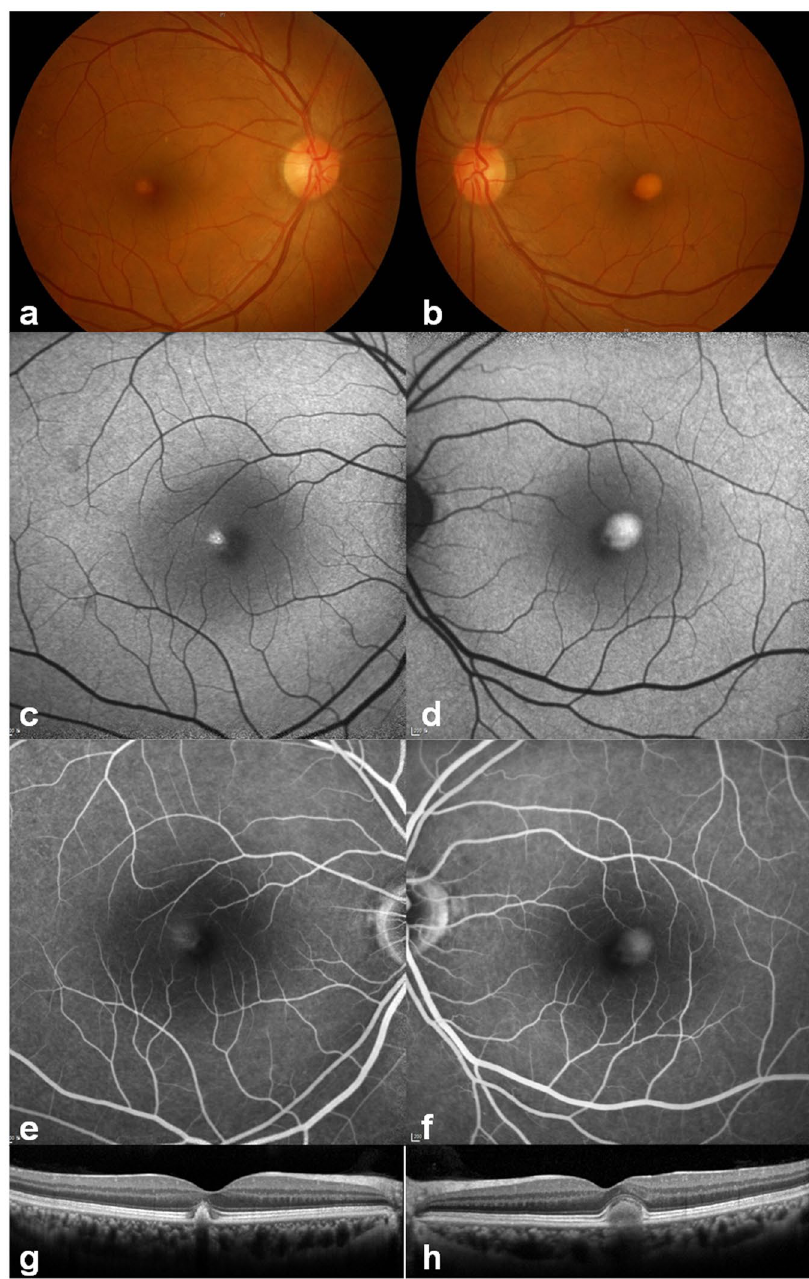
Figure 1. Clinical features of the patient. (a , b) Color fundus photographs showing bilateral, round subretinal yellowish deposits (vitelliform) in the posterior pole. (c , d) Blue light autofluorescence imaging showed intense hyper-autofluorescence at the corresponding yellowish deposit lesions. (e , f) Corresponding lesions showed diffuse hyperfluorescence in the late-phase images of fluorescein angiography. (g , h) Horizontal spectral-domain optical coherence tomography images through fovea showed well demarcated subretinal hyper-reflective material in the affected